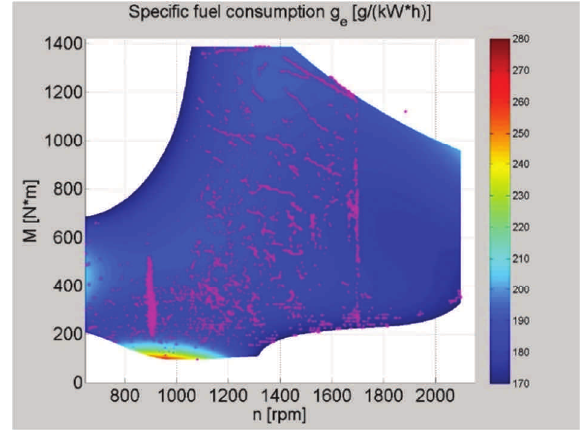
Fig. 10. General characteristics obtained from operational data: static state duration 0.5 s; derivative limits: 20 N ∙ m/s, 20